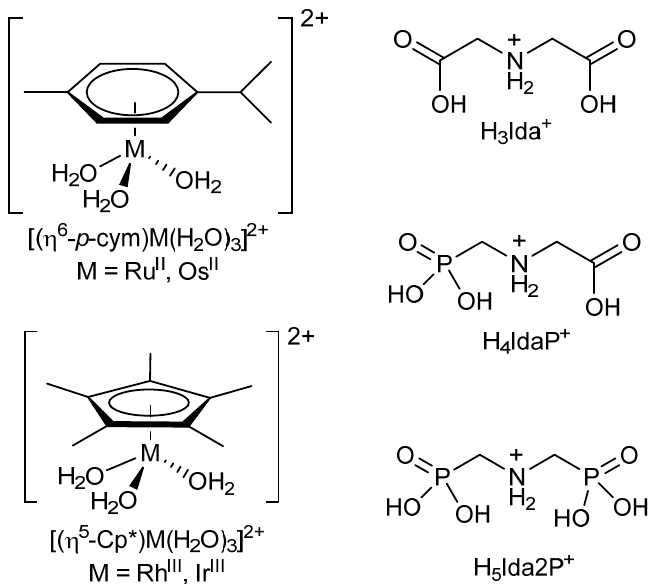
Scheme 1. Structure of the cations and the fully protonated forms of the ligands studied.